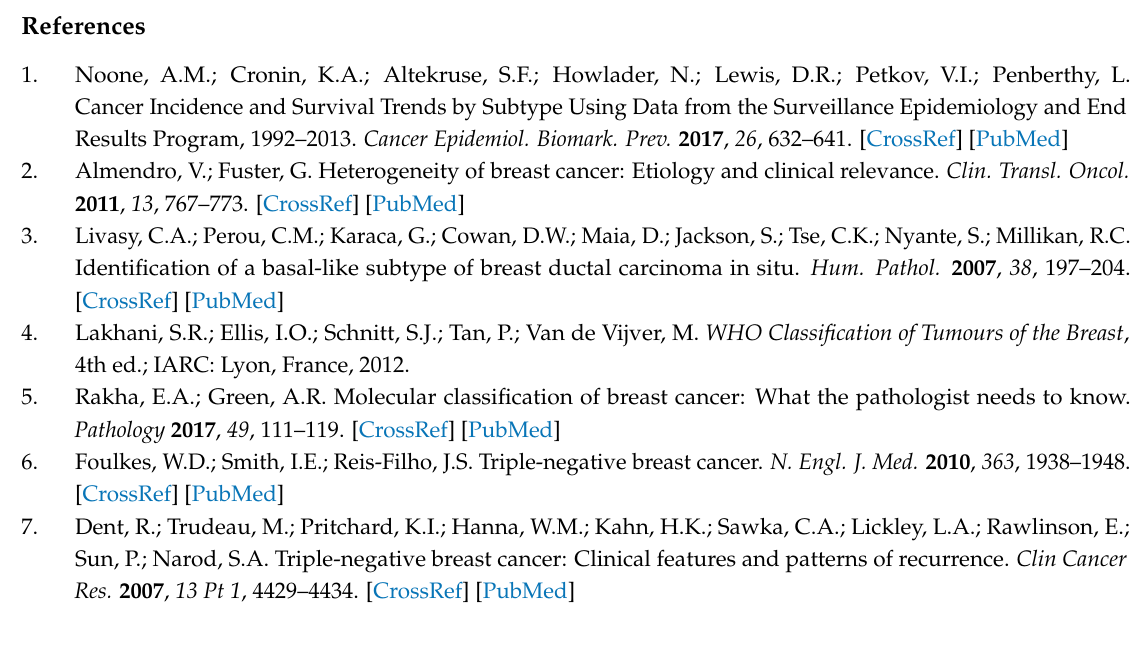
Figure S1: UV/Vis absorption spectra of CD and SMA–CD incubated at 37 ◦ C in PBS 48 h. (A) Superimposing UV/Vis absorption spectra of CD measured in PBS at 0, 24, and 48 h; (B) Superimposing UV/Vis absorption spectra of SMA–CD measured in PBS at 0, 24, and 48 h. All experiments were performed in triplicate, Figure S2: CD interaction with plasma proteins. The size of the CD complex with plasma proteins was determined by dynamic light scattering using the using the Malvern ZEN3600 Zetasizer Nano series. The Results were obtained from three independent